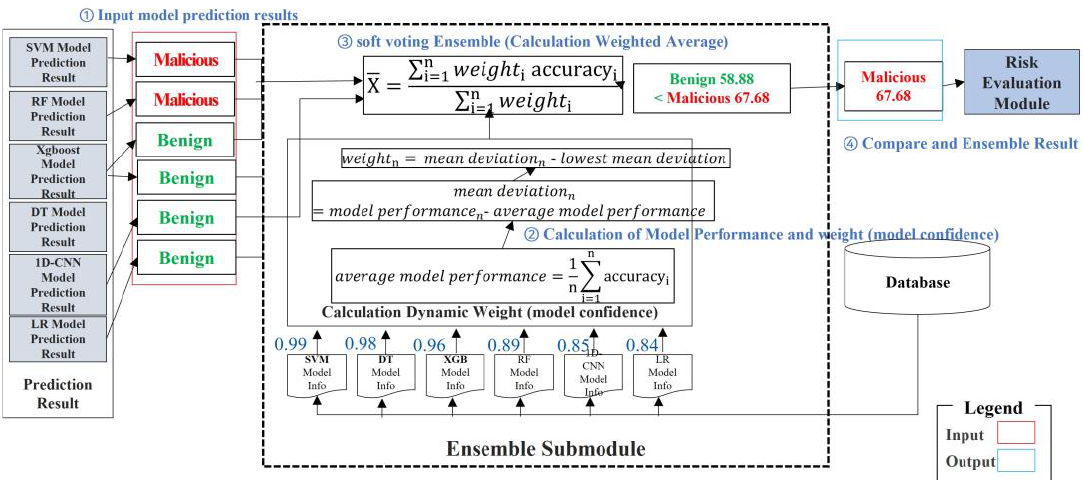
Figure 5. Ensemble Machine Learning Prediction Analysis Process.